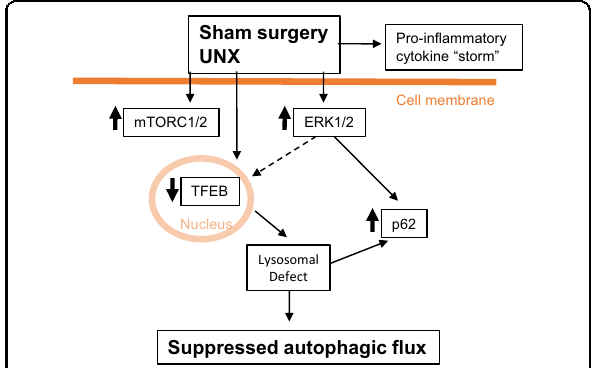
Fig. 8 Surgical procedures suppress autophagic fl ux. Sham surgery and unilateral nephrectomy (UNX) resulted in an increase in pro-in fl ammatory cytokines in the serum. There was an increase in mTORC1/2 proteins and phosphorylated ERK1/2 (pERK1/2) in the kidney in sham surgery and UNX. The increase in pERK1/2 resulted in an increase in p62. ERK1/2 potentially inhibited (dotted line) TFEB nuclear localization and the lysosomal defect seen in sham surgery and UNX. A systemic cytokine “ storm ” , a large increase in pERK1/2, a lysosomal defect and suppressed autophagic fl ux caused by sham surgery may confound the interpretation of results of autophagy studies using animal models requiring surgical